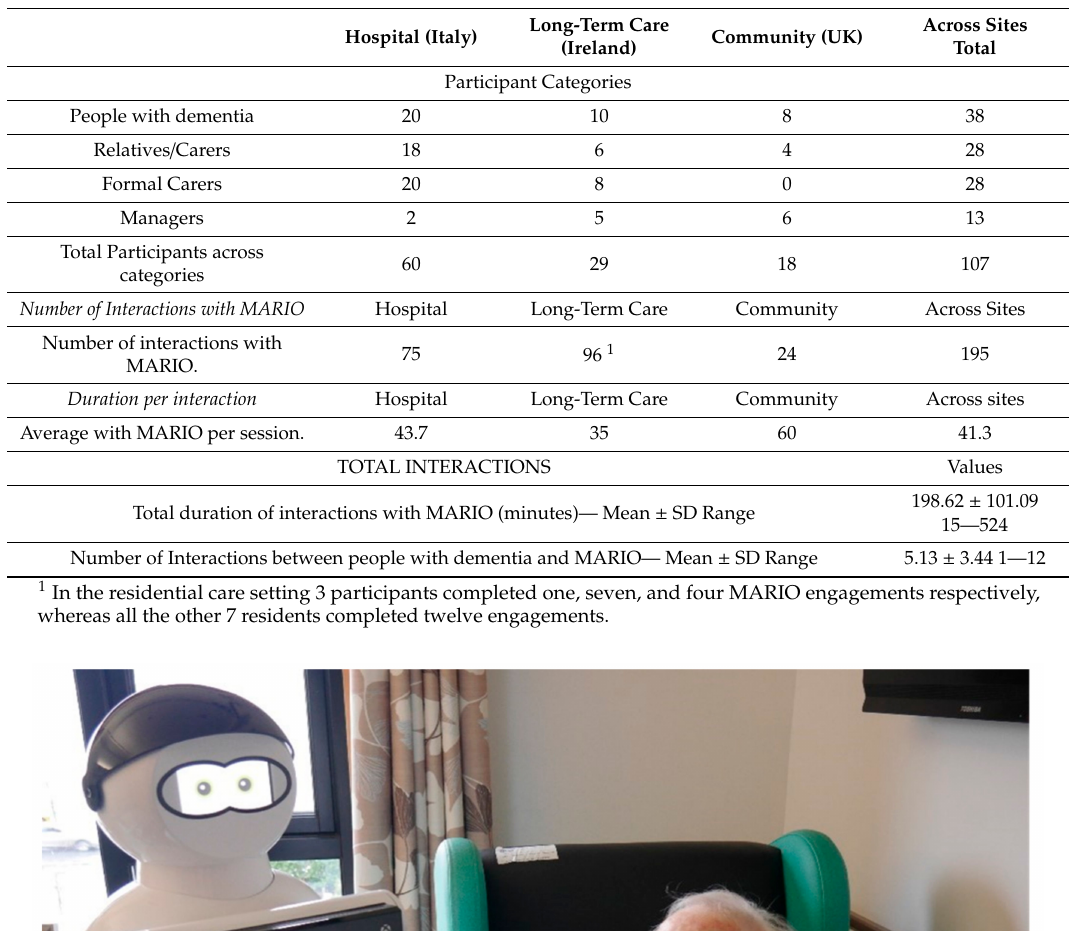
Table 1. Participants numbers. Interactions with MARIO.